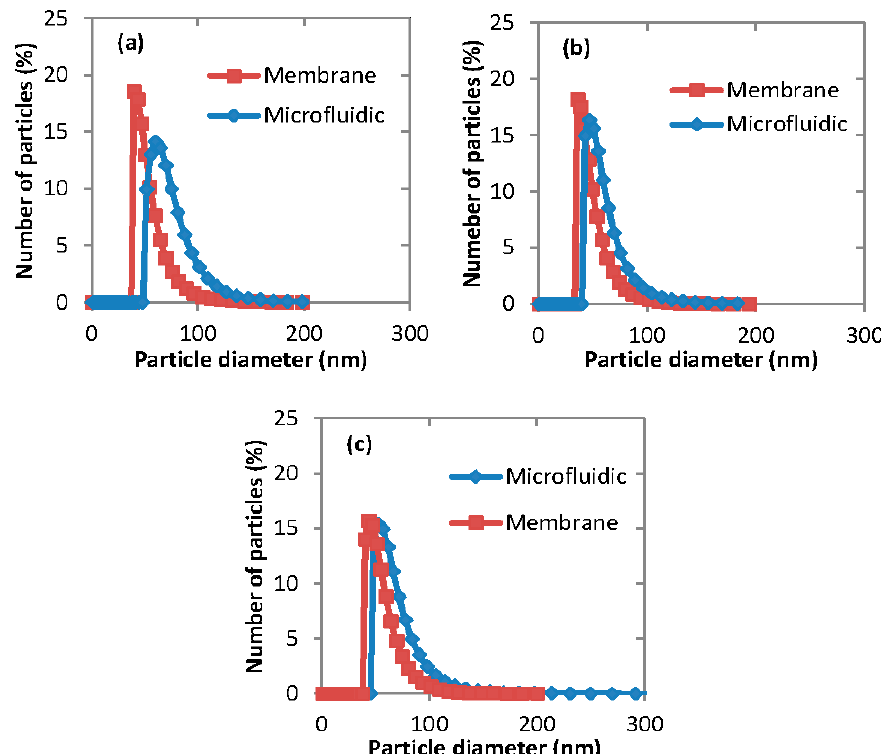
Figure 6. The particle size distribution of drug-free micelles produced using membrane and microfluidic techniques from different copolymers: ( a ) PEG- b -PCL (A); ( b ) PEG- b -PCL (B); and ( c ) PEG- b -PCL (C). The organic phase was 1 mg·mL − 1 PEG- b -PCL in acetone.